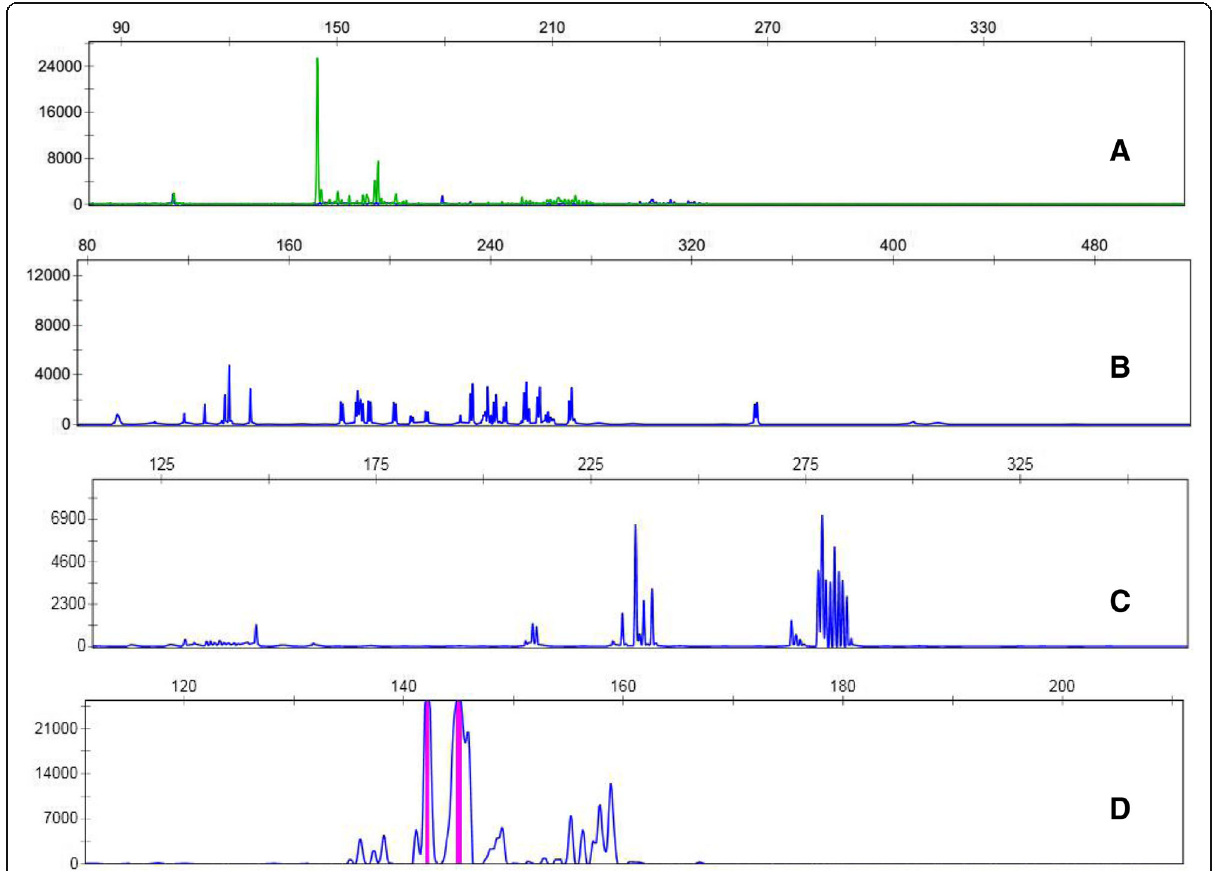
Fig. 4 PCR analysis for TCR γ receptor and IgH gene rearrangement on formalin-fixed, paraffin-bedded tissue sections from colon biopsy specimens (2017). Clonal TCR γ receptor gene rearrangement was found ( a ), but IgH( b ), IgK ( c ), IgL ( d ) gene rearrangement was not